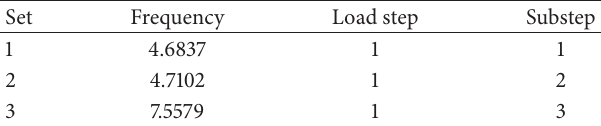
Table 4: The modal